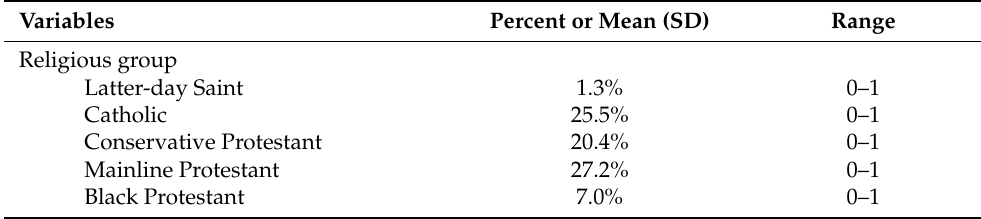
Table 1. Descriptive